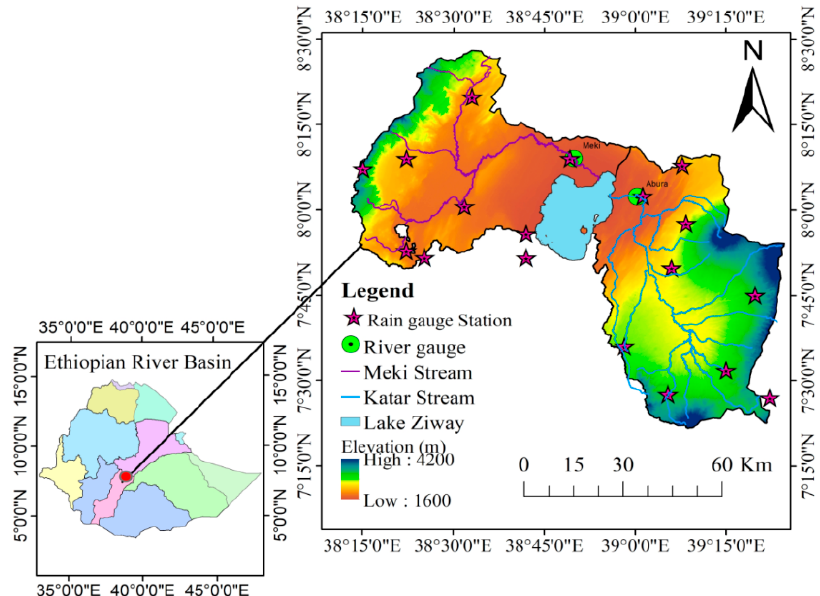
Figure 1. Location of the study area relative to the Ethiopian river basin with topography and location of rain gauge and stream gauge stations in Lake Ziway drainage